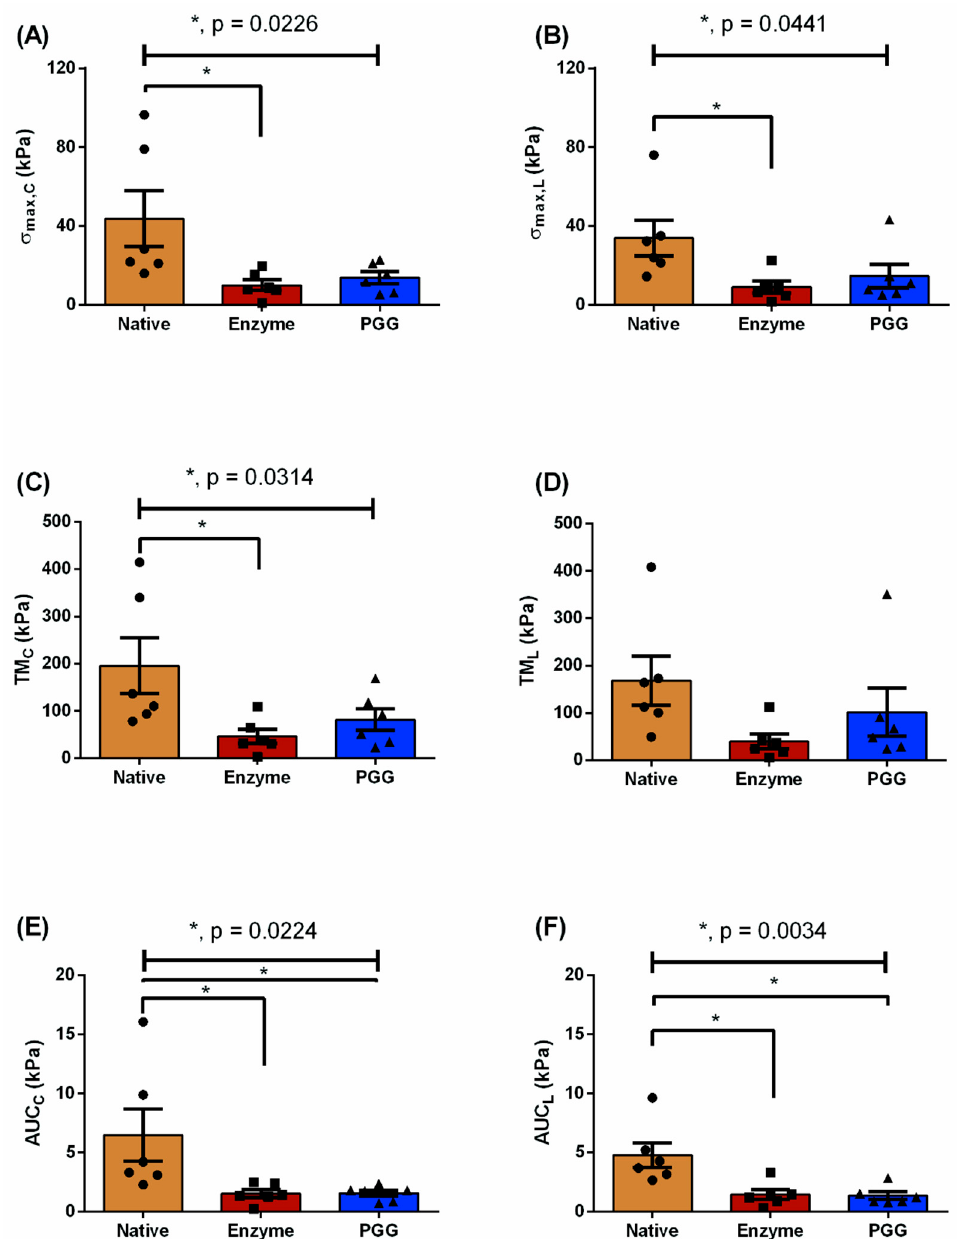
Figure 4. Biomechanical parameters for the native (N), elastase-digested (E), and PGG-treated (P) porcine abdominal aorta specimens, which are represented as mean ± SEM. Maximum stress (kPa) is displayed in both circumferential ( σ max , C ) ( A ) and longitudinal orientations ( σ max , L ) ( B ). ( C , D ) tensile moduli (TM) (kPa) and ( E , F ) area under the curve (AUC) (kPa) for both circumferential and longitudinal directions, respectively. *denotes significance across the groups ( p < 0.05).